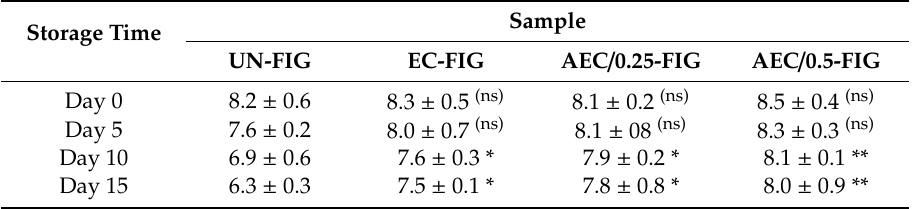
Table 3. Changes in antioxidant activity (EC50) occurring during shelf-life after 5, 10, and 15 days of storage at 4 ◦ C with di ff erent